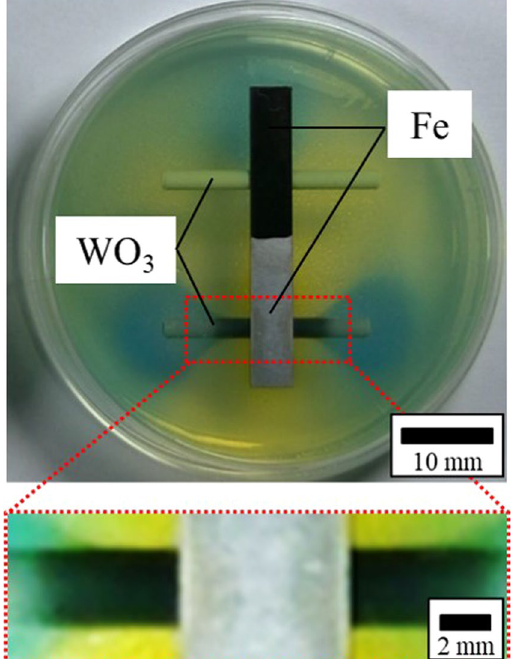
Figure 3. Image of Fe plate and WO 3 rod inserted in BTB agar gel and magnified image of WO 3 rod (red